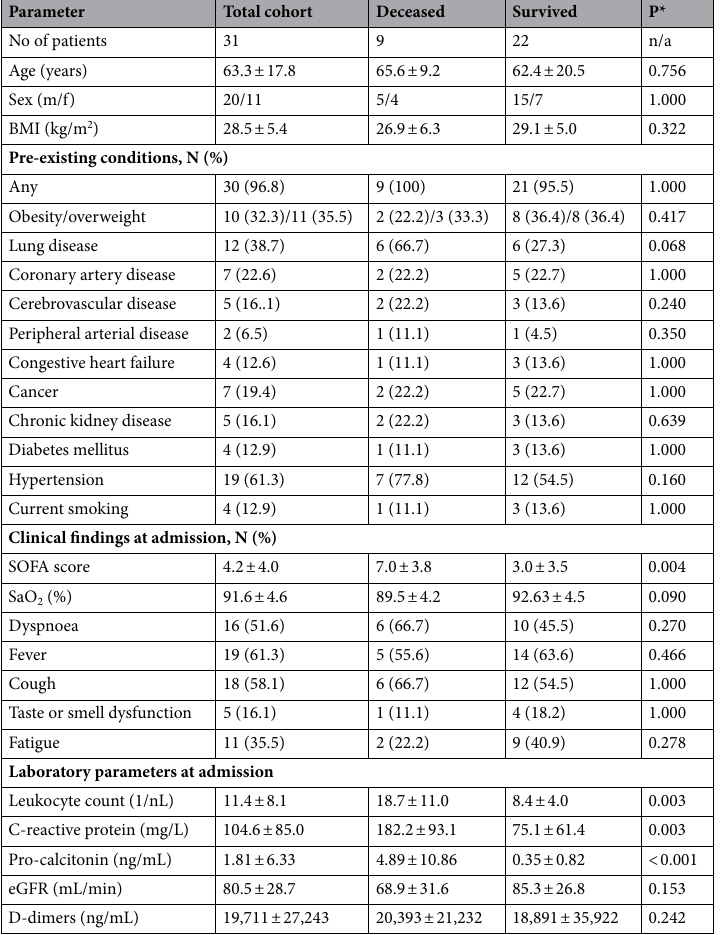
Table 1. Baseline characteristics of the patients. BMI, body mass index; eGFR, estimated glomerular filtration rate; SaO 2 , arterial oxygen saturation; SOFA, Sequential organ failure assessment score; n/a, not applicable; n.s., not significant. Data are mean ± standard deviation or N (%) if marked. * P values were calculated using Mann– Whitney U-test for continuous variables and Chi 2 test for categorical